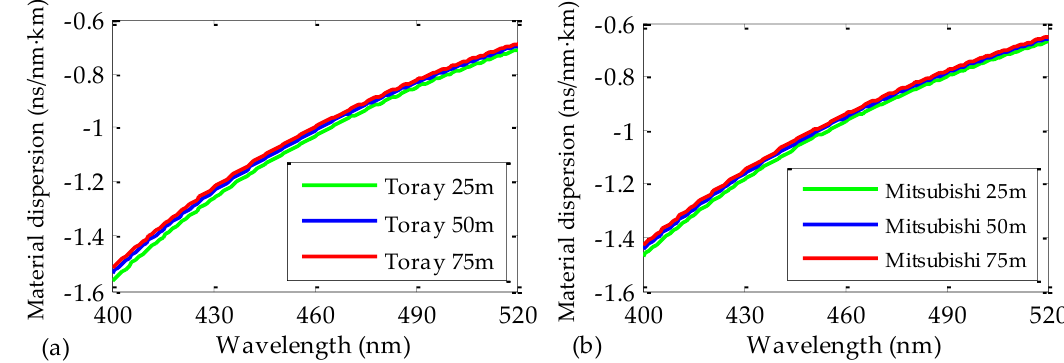
Figure 4. Material-dispersion coefficients obtained for POFs made by Toray ( a ) and by Mitsubishi ( b ). Three different lengths of fiber were employed for each manufacturer: 25 m (green lines), 50 m (blue lines), and 75 m (red lines).